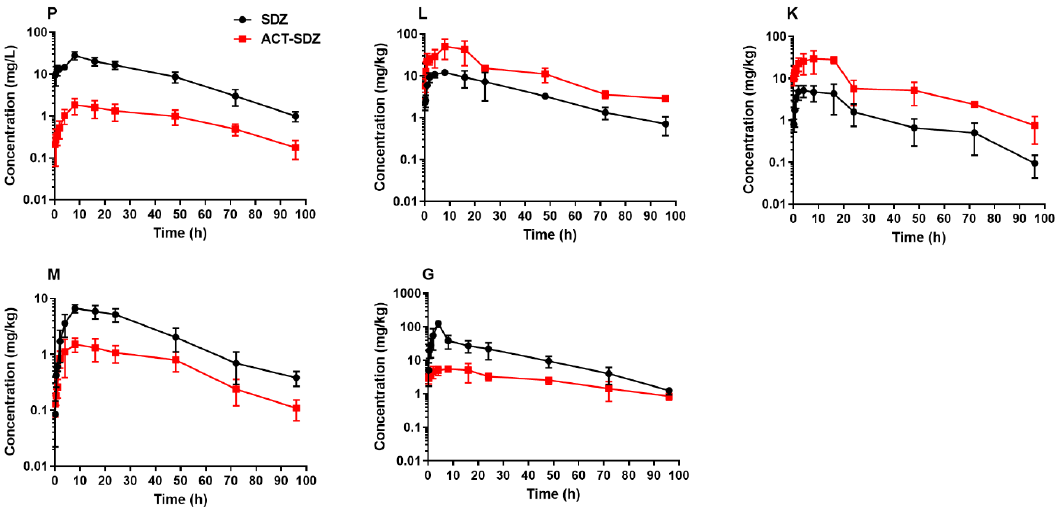
Figure 2. Semi-logarithmic concentration-time profiles of sulfadiazine and N-acetyl sulfadiazine in plasma (P), liver (L), kidney (K), muscle+skin (M), and gill (G) of grass carp ( Ctenopharyngodon idella ) following a single oral dose of sulfadiazine at 50 mg/kg at 24 °C. Abbreviations on the figure: SDZ, sulfadiazine; ACT-SDZ, N-acetyl sulfadiazine.